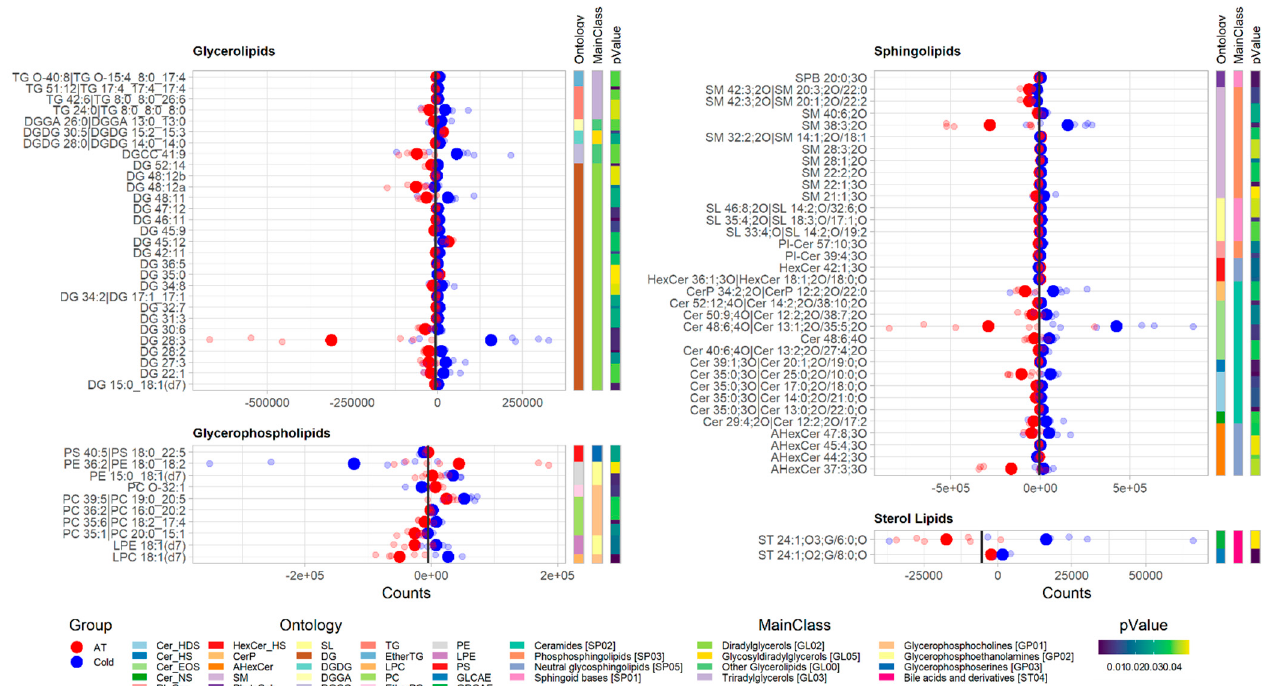
Figure 6. Plots of significantly different ( p < 0.05) lipid classes within lipid categories in plasma samples from new-born lambs kept at ambient temperature (20–22 °C, AT in red) vs. those kept at cold temperature (4 °C, cold in blue), after 2 days of exposure. Each row of dots represents a lipid metabolite with respect to its ion counts obtained from LC-MS analysis, where big dots represent the mean and smaller dots represent the individual values ( n = 6 in each group). The vertical bold black line represents the average count value across all plasma datasets, after 2 days of exposure.